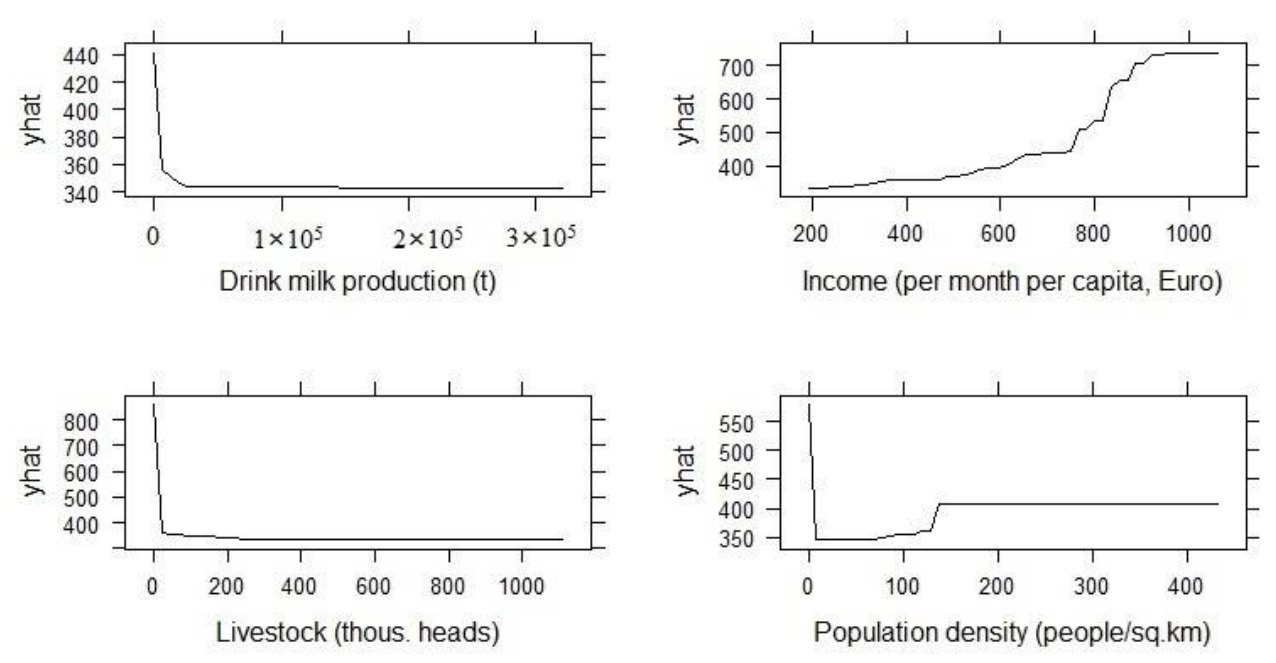
Figure 6. Variable importance of predictor variables using machine learning random forest (RF) model.